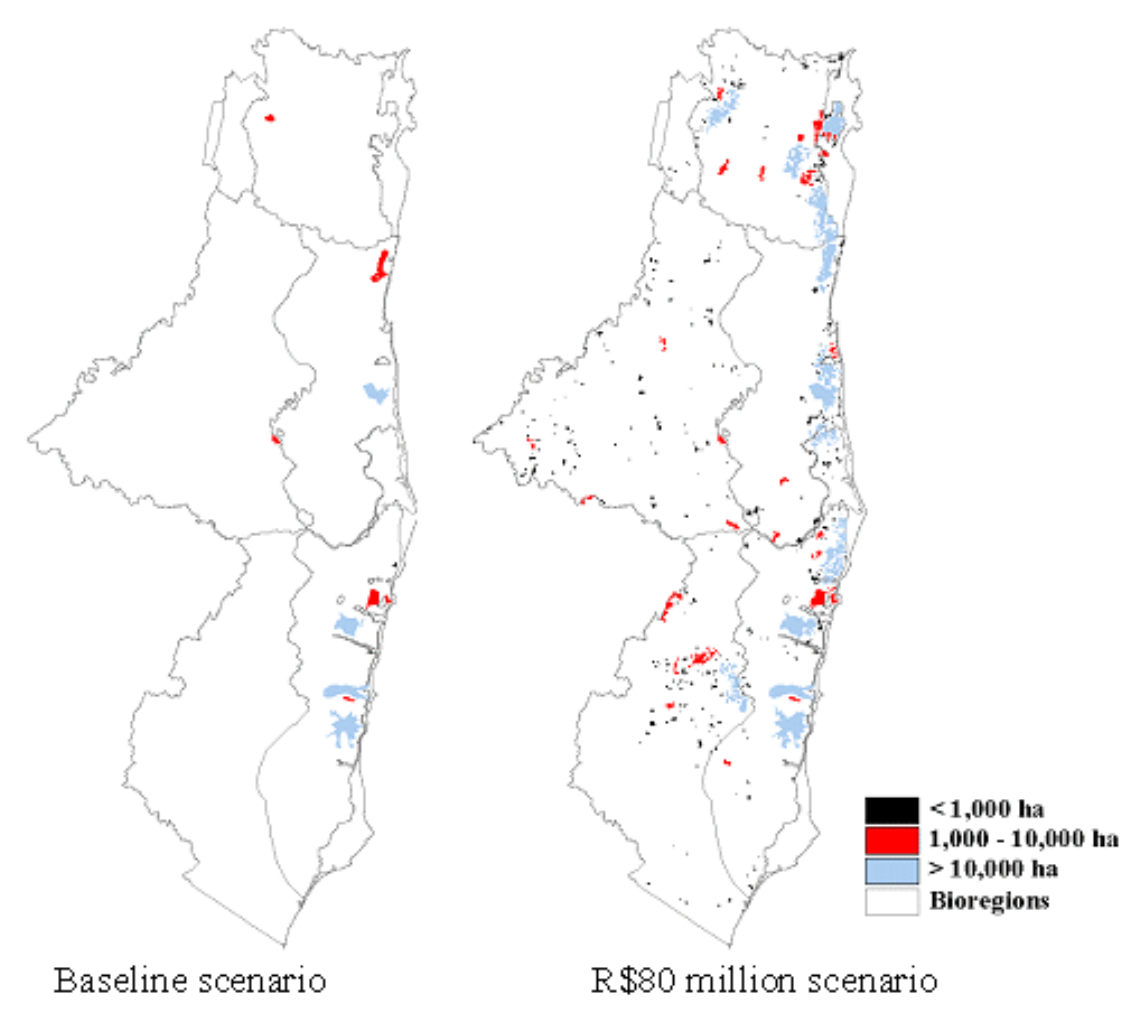
Fig. 4. Map of conserved forest fragments in R$0 and R$80 X 10 6 budget